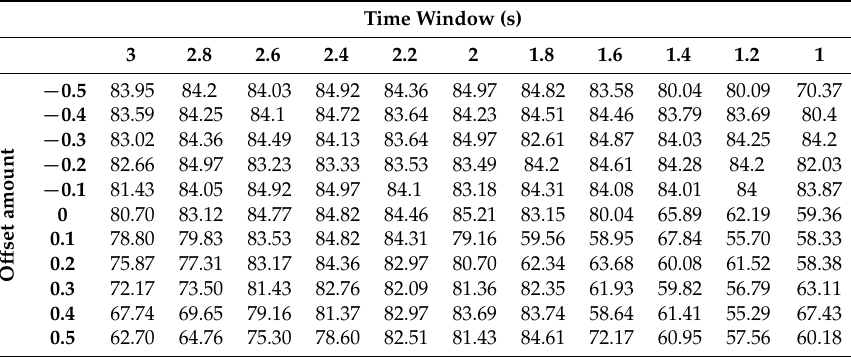
Table 3. The average classification accuracy for 121 iterations (offset + time